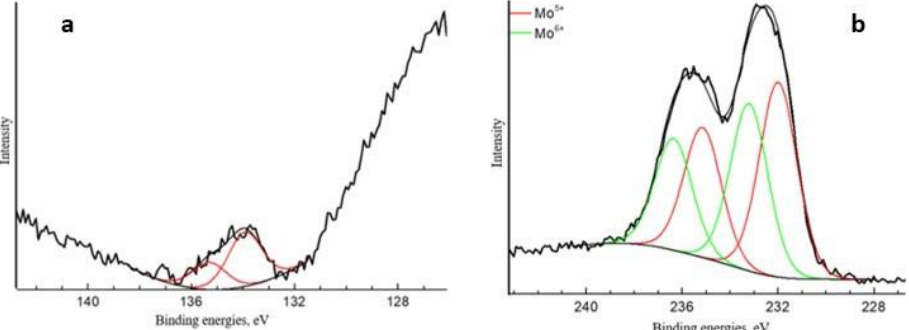
Figure A3. P2p ( a ) and Mo3d ( b ) XPS spectrum of the test sample.